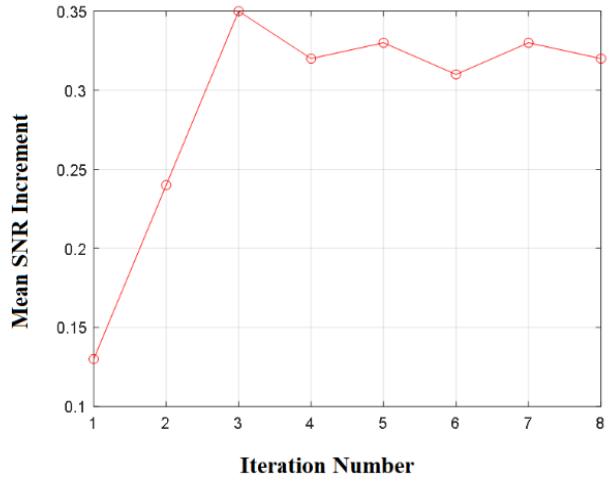
Figure 4. Relationship between the number of reconstruction iterations R and the mean SNR incre- ment after processing.